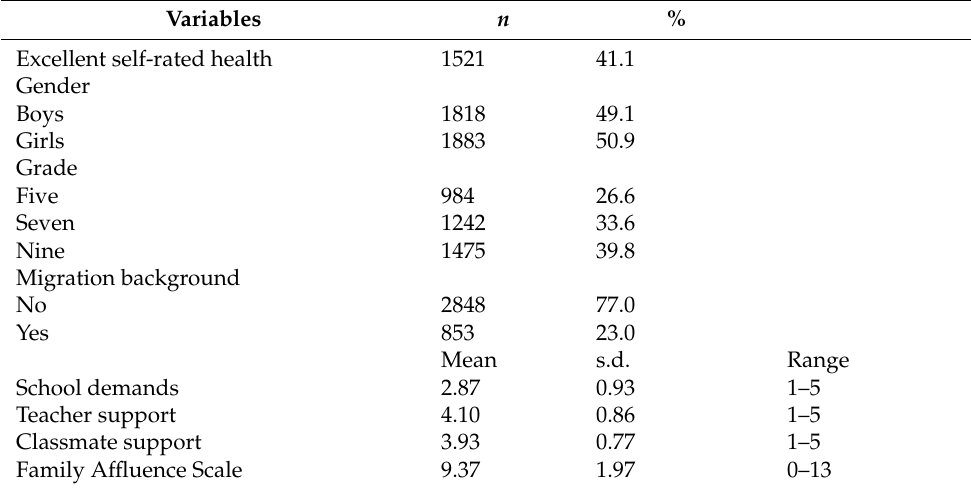
Table 1. Descriptive statistics ( n = 3701).